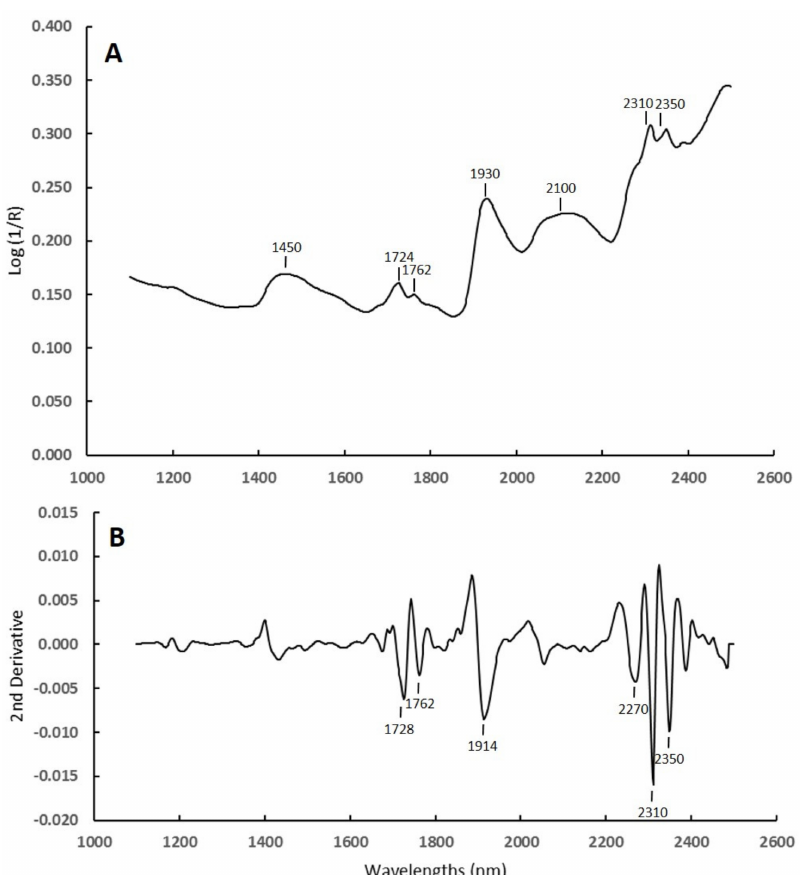
Figure 2. Near infrared reflectance spectra used to build a prediction model for diet composition of Pyrenean chamois. It shows the bands of the main absorption. ( A ) Raw average spectrum of fecal samples, ( B ) the same spectrum after a second derivative and detrend treatment (R = reflectance).